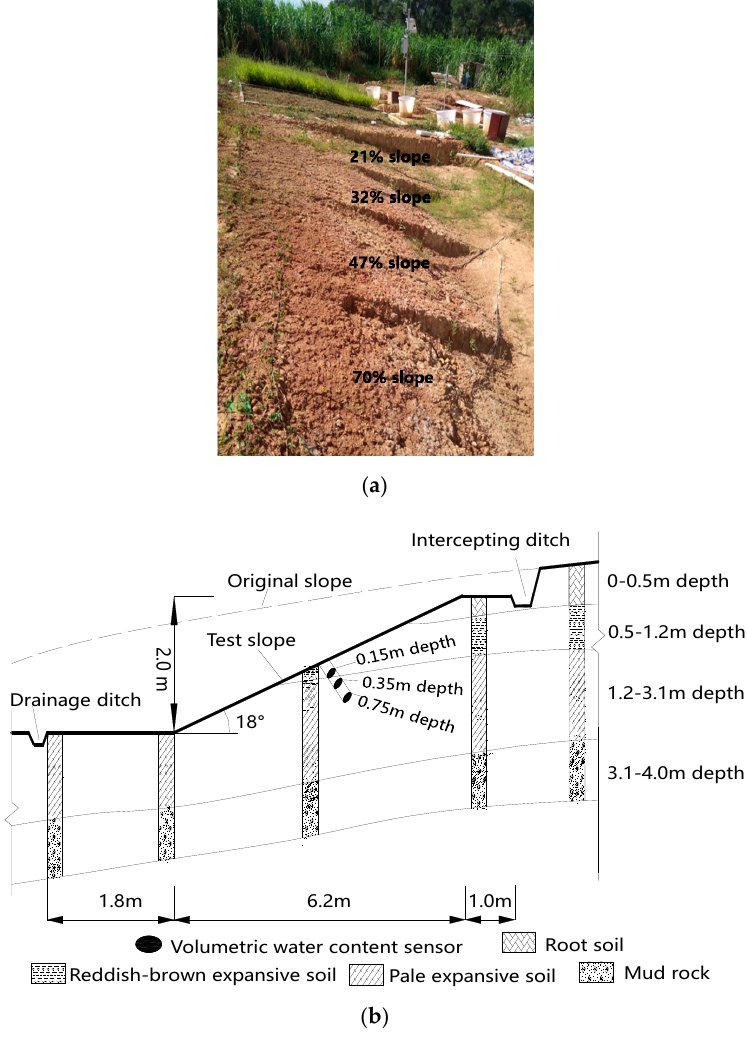
Figure 1. Experimental slopes: ( a ) Layout of four slopes; ( b ) cross-section of 32% slope.